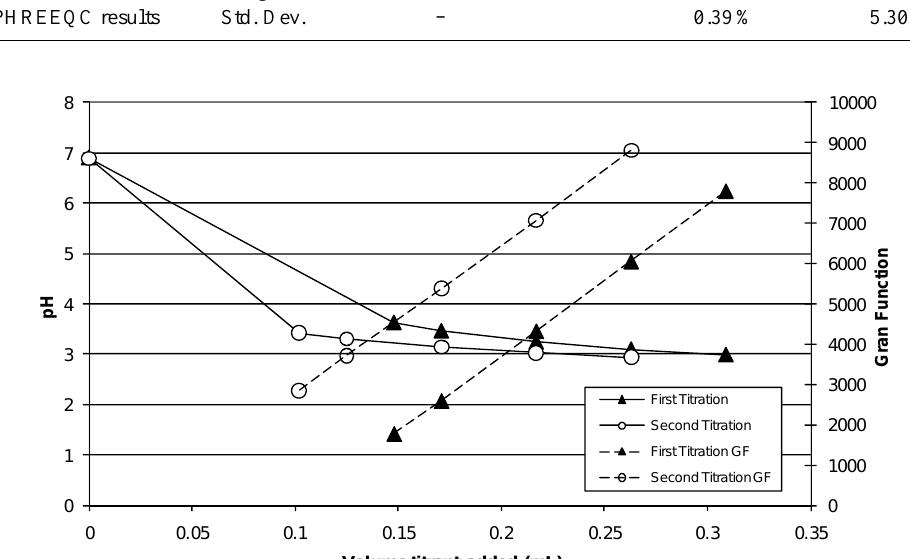
Fig. 1. Example titration curve and Gran function (GF) plot for Oyster River Figure 1. Example titration curve and Gran function (GF) plot for Oyster River water.